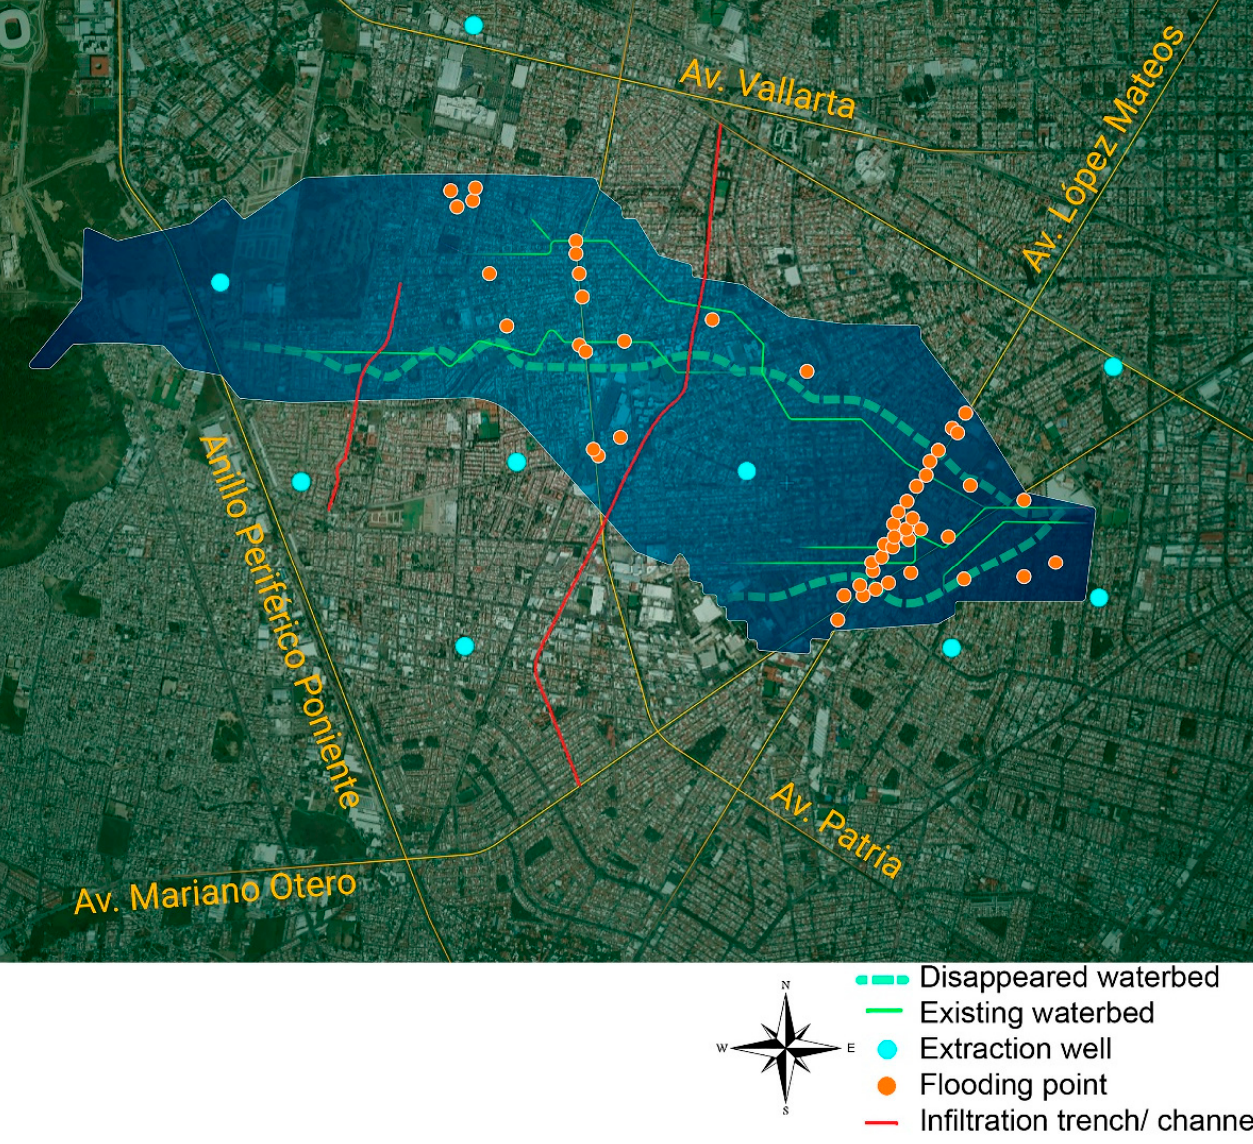
Figure 2. Micro-basin El Chicalote: hydrological context. Table 1. Analyses elements and data gathered for the assessment.